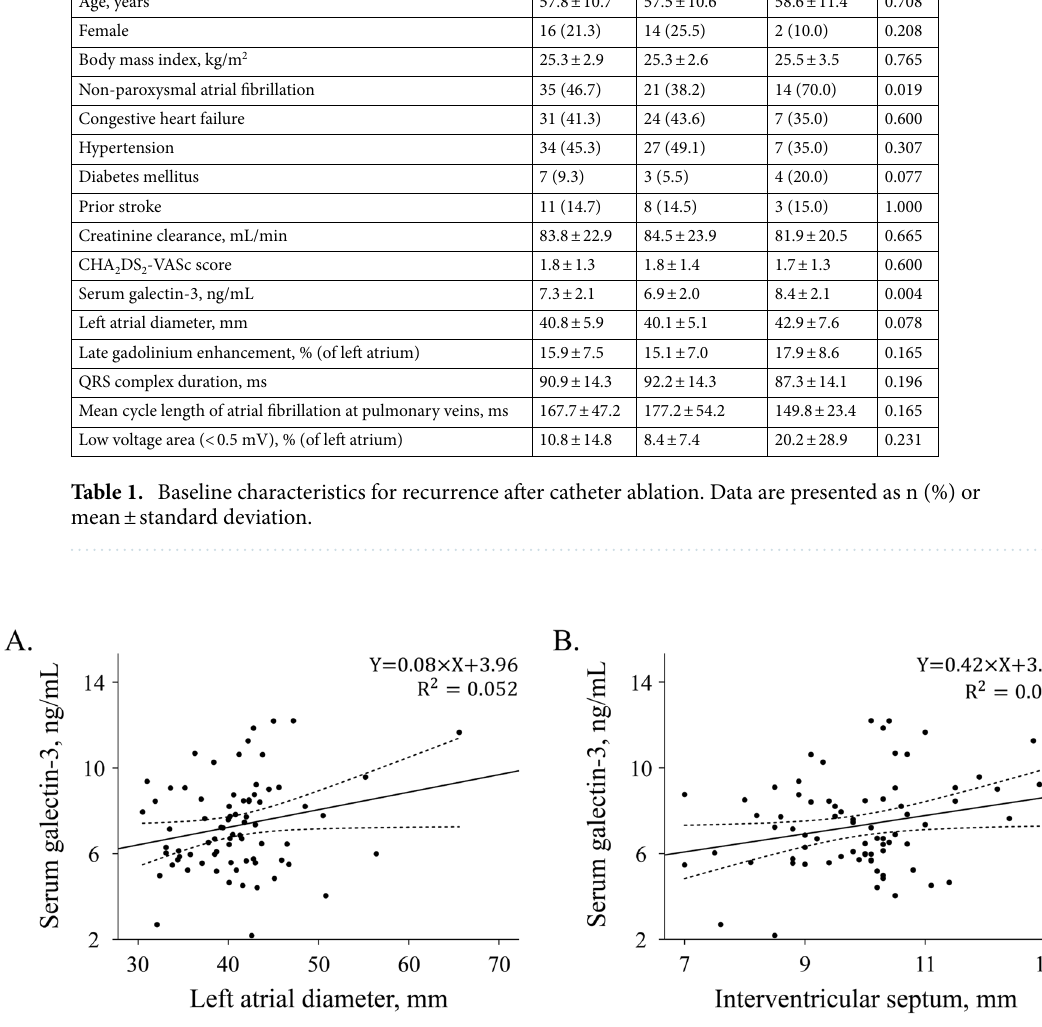
Figure 2. Scatter plot with Pearson correlation analysis. Significant positive correlation was found between galectin-3 and left atrial diameter ( A ), serum galectin-3 and left interventricular septum ( B